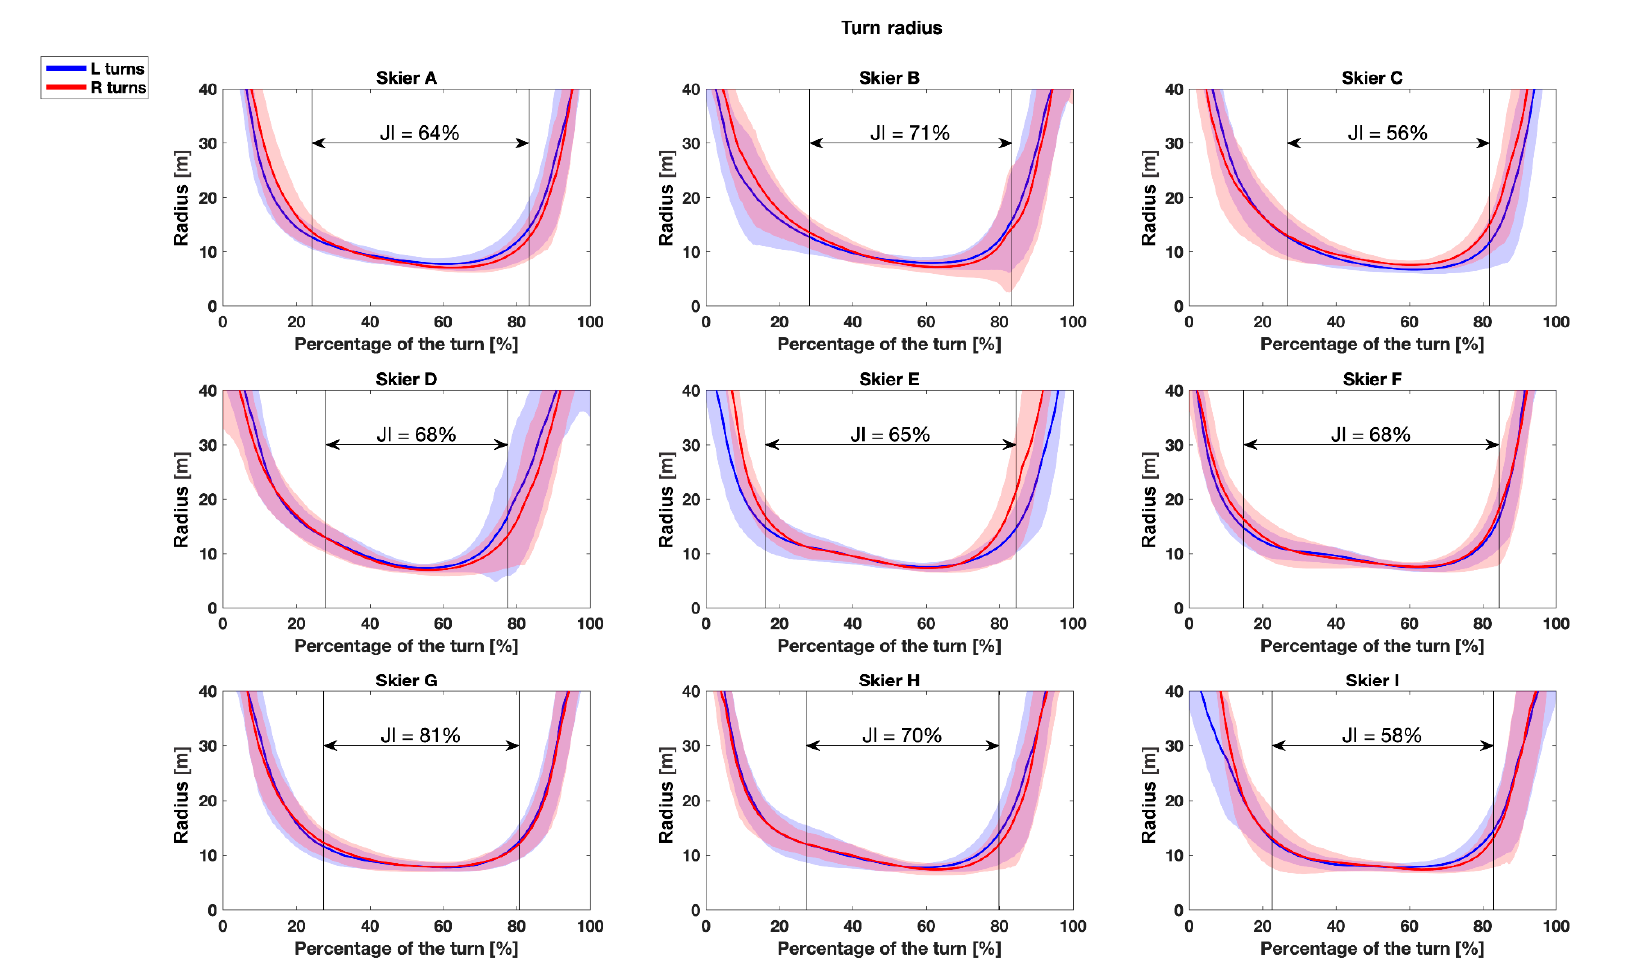
Figure 5. The turn radii during the steering phase of left and right turns by 9 elite slalom skiers ( A – I ) and corresponding Jaccard indices (JI). The two vertical lines indicate the beginning and end of the steering phase.